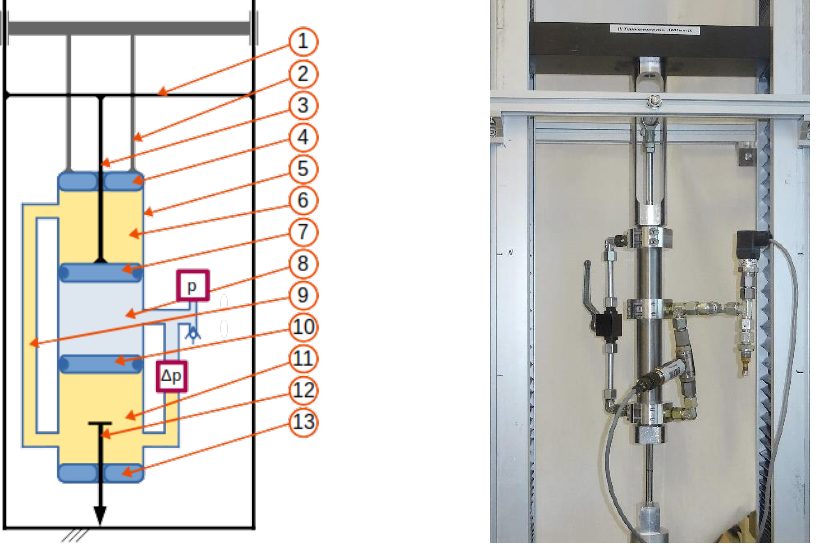
Figure 5. Principle ( left ) and actual setup ( right ) of the Single Friction Point Test Rig 2: floating piston/tube. (1) frame; (2) actuation; (3) rod; (4) rod guide assembly; (5) tube; (6) upper oil volume; (7) displacement piston; (8) gas volume; (9) connection pipe; (10) floating piston; (11) lower oil volume; (12) secondary rod; (13) secondary rod guide assembly